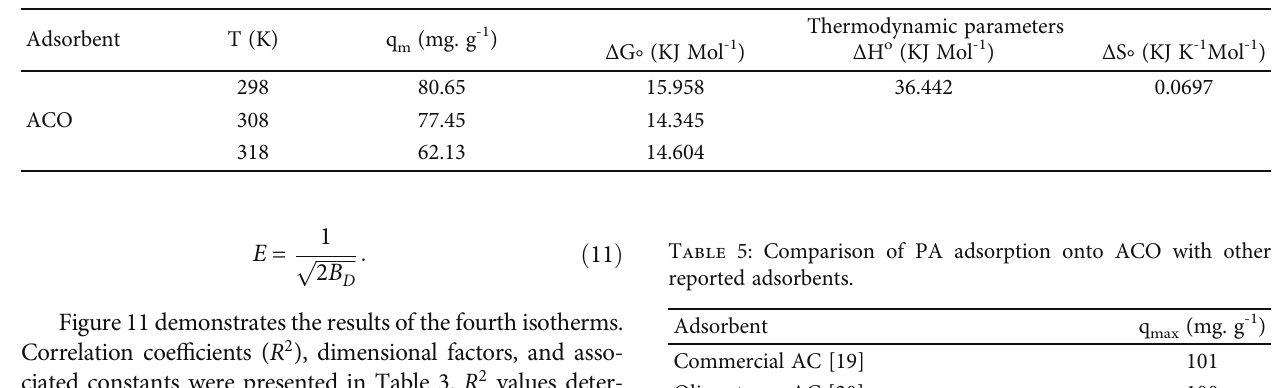
Table 4: Thermodynamic parameters of PA adsorption onto ACO.